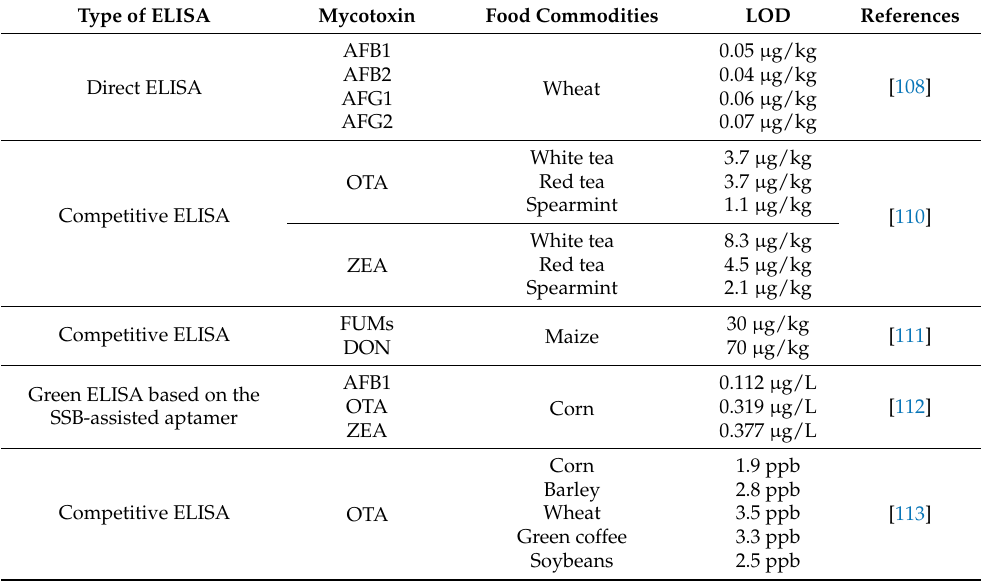
Table 3. ELISA method used in the detection and of mycotoxins in various types of food. Type of